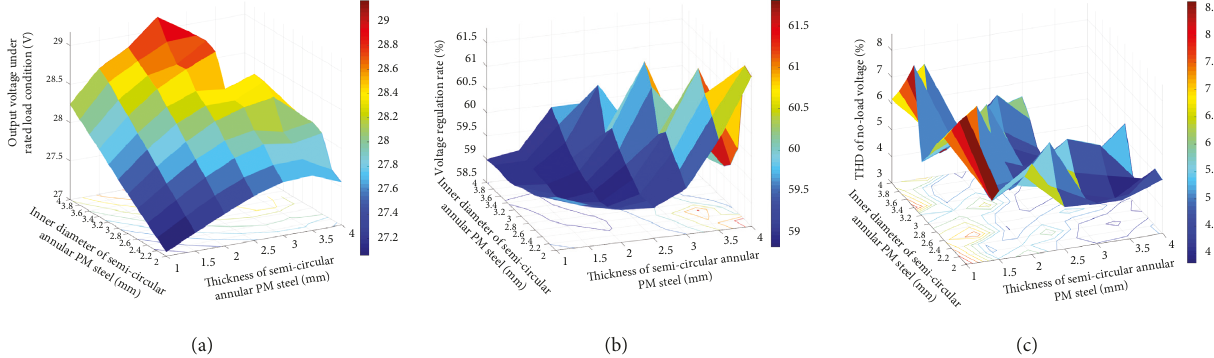
Figure 16: Variation diagrams of generator output performance with different thicknesses and inner diameters of semicircular annular PM steel: (a) output voltage under rated load condition; (b) voltage regulation rate; (c) THD of no-load voltage.